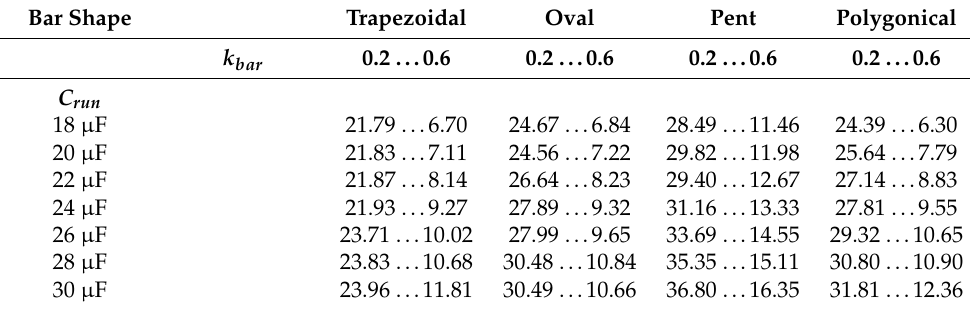
Figure 9. Variation of rotor bars resistance coefficient ( left ) and leakage reactance coefficient ( right ) as a function of the SPIM’s slip for different k bar values. Table 12. The SPIM’s rotor ohmic losses for the minimum and maximum k bar values and indicative corresponding C run values, for rotor bars of trapezoidal, oval, pent and polygonical shape.